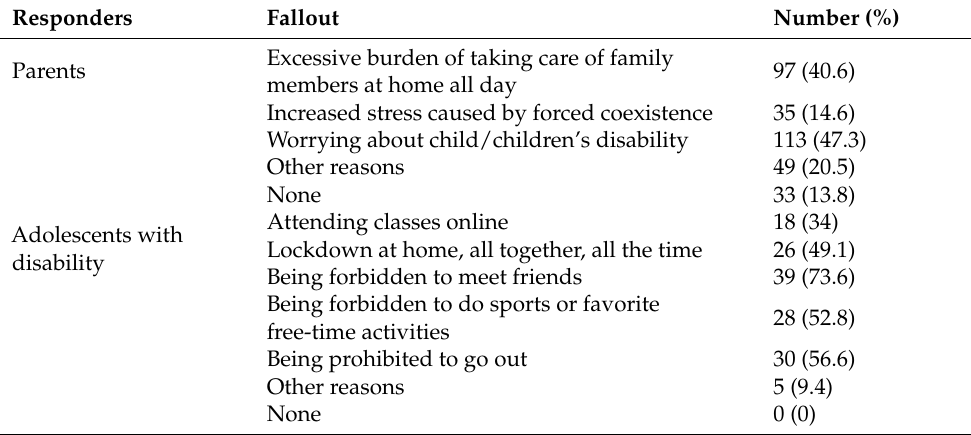
Table 4. Fallout of the lockdown.